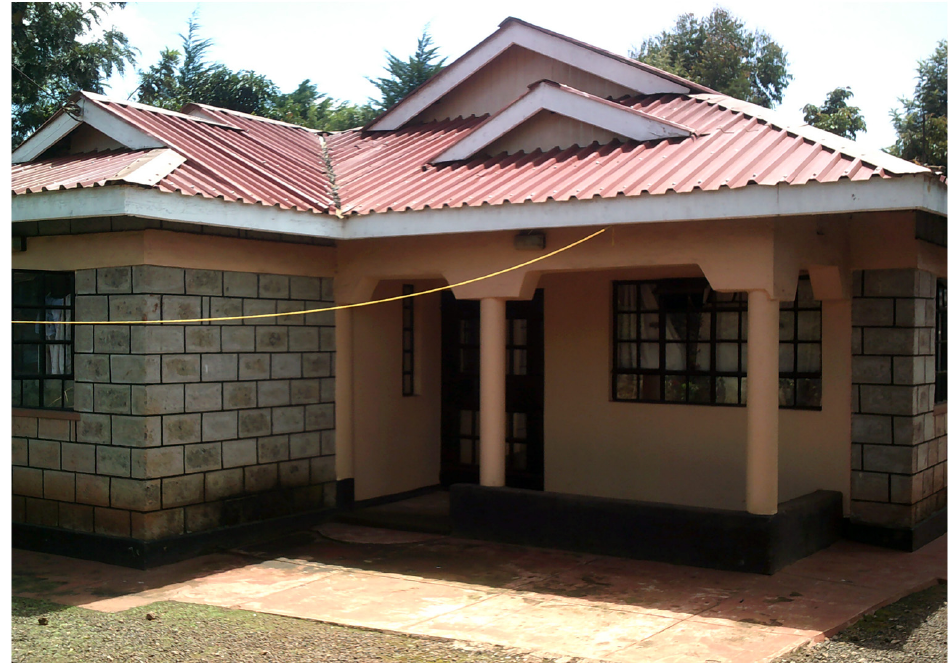
Figure 3. A community house that houses many refugees. The house is always full and congested.